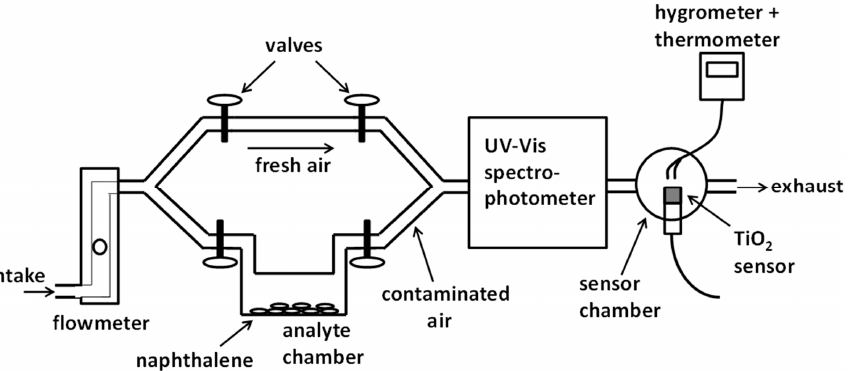
Figure 2. Diagram of the overall experimental apparatus with the major components. Not shown in this diagram is the UV-emitting LED array used to illuminate the TiO 2 sensor. The LED array would be on top of the sensor out of the page (See pictures on next Figure 3).